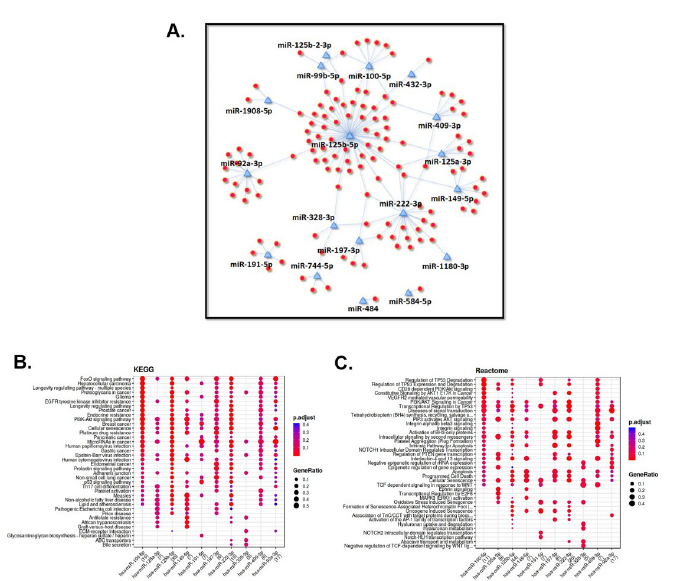
Fig 7. Predicted miRNA-target mRNA interaction in gestational diabetes mellitus (GDM) during early gestation. A). The miRNA-Target mRNA network depicts targets of the top 20 differentially expressed EV-derived miRNAs from GDM in the first trimester of pregnancy. Blue triangles represent miRNAs while red dots refer to their targets. Dot plots represent functional enrichment analysis depicting target genes of selected miRNAs. The Y-axis displays the annotation categories KEGG pathways ( B ) and Reactome pathways ( C ) while the X-axis depicts the selected miRNAs.